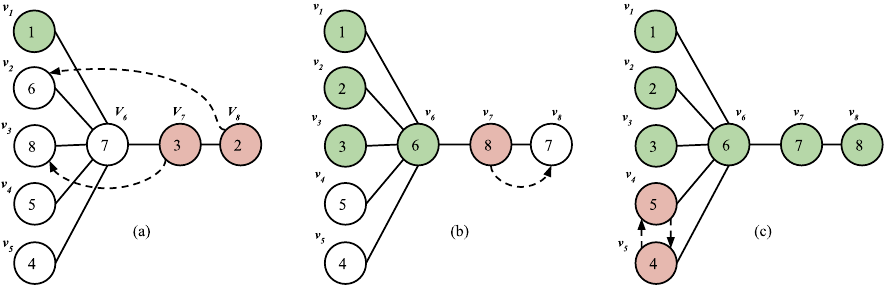
Figure 2. Illustration for Algorithm A b . The star vertices are v 1 , v 2 , v 3 , v 4 , v 5 and the path vertices are v 6 , v 7 , v 8 . ( a ) (i) S min = 3, Swaps = 2; (ii) S min = 2, Swaps = 3. ( b ) P max = 8, Swaps = 1. ( c ) Unhomed Markers are 5 and 4, Swaps =